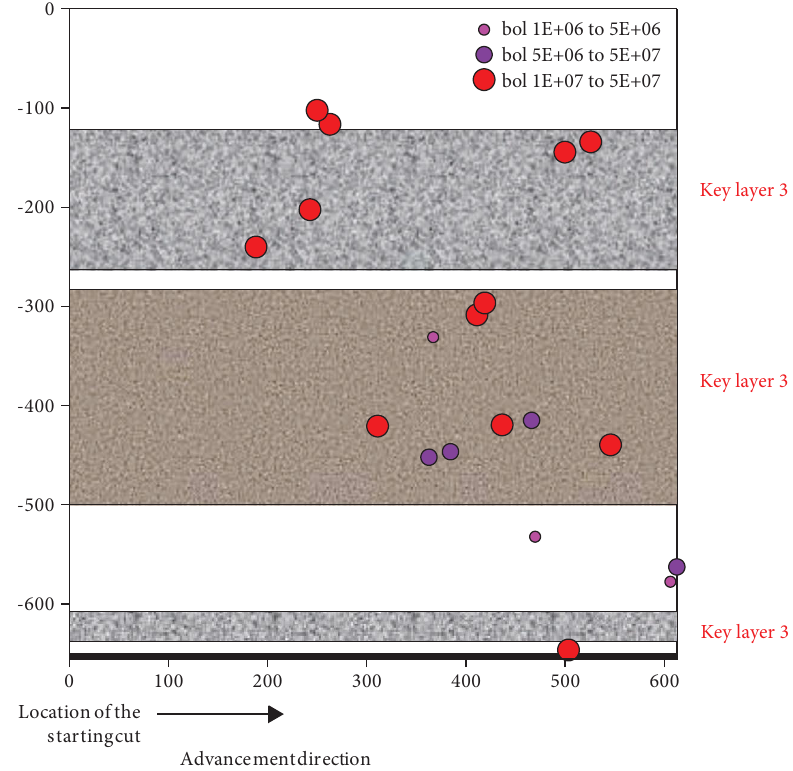
Figure 11: Profle of the location of strong mine tremors at panel 63upper06.